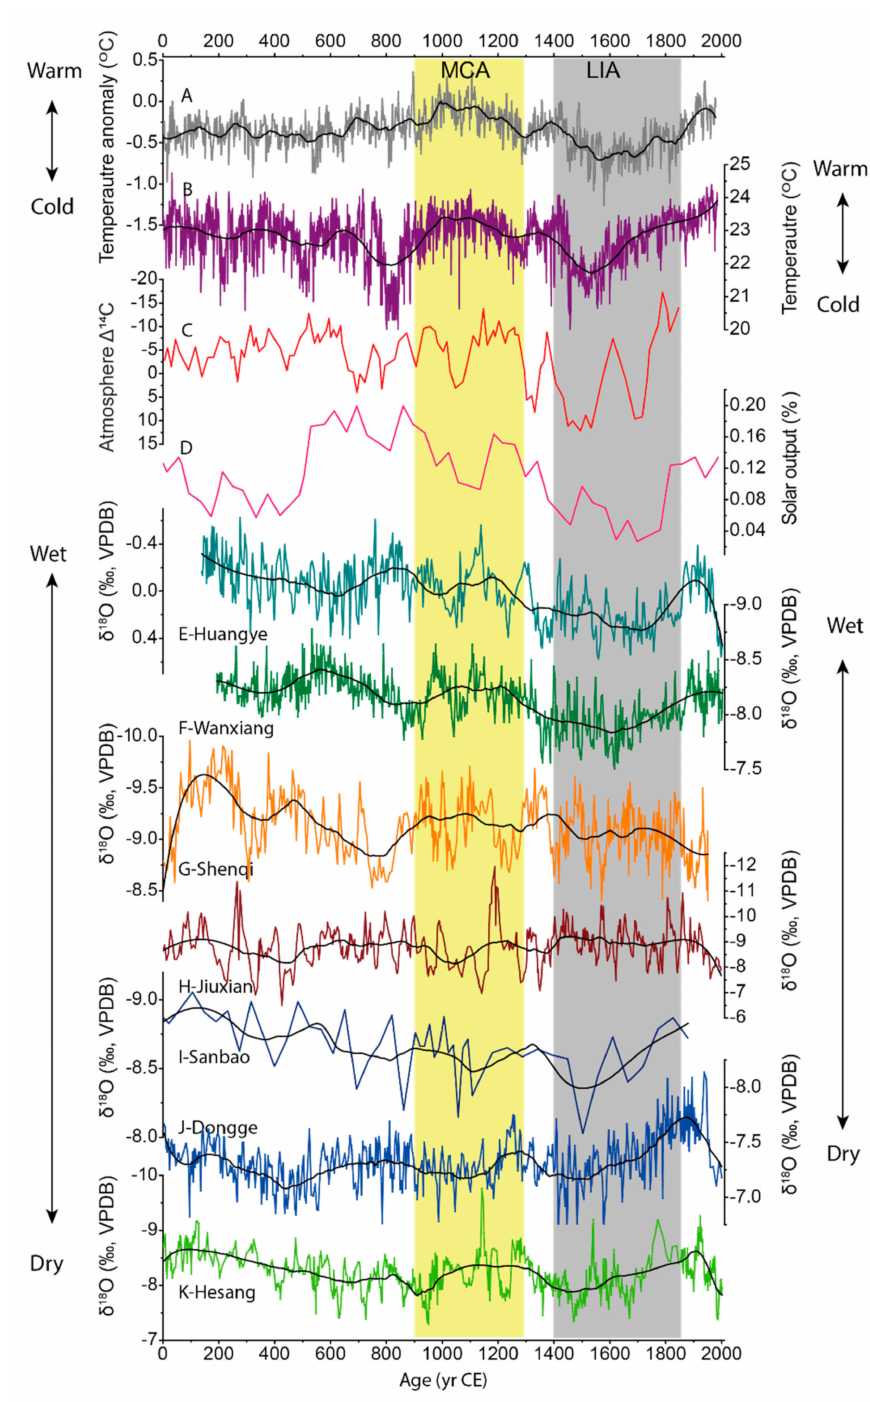
Figure 9. Chinese speleothem δ 18 O, solar activity and temperature curves for the last 2000 yrs. ( A ) Temperature anomaly for the Northern Hemisphere [236]; ( B ) Warm season temperature in northern China from Shihua Cave [127,225]; ( C ) Atmospheric ∆ 14 C [237]; ( D ) Solar output [238]; ( E – K ) Speleothem δ 18 O records from Huangye [63], Wanxiang [10], Shenqi [235], Jiuxian [75], Sanbao [113], Dongge [8] and Heshang caves [15]. The black, solid line in panels A and B is the 100-year running mean. Black lines in panels C–K is the 50-year running mean. Yellow and gray bars show the intervals best defining the Medieval Climate Anomaly (MCA) and Little Ice age (LIA) based on the Northern Hemispheric temperature anomaly ( A ),